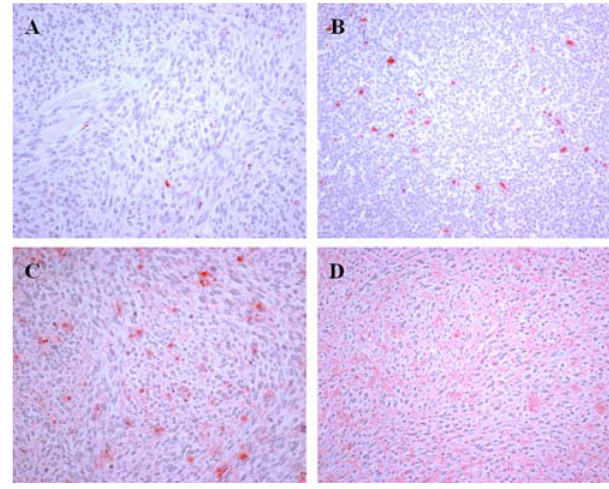
Figure 3. Analysis of tumor evolution by HES histological staining after IRE. A: control; B, C, D, E and F: respectively 1, 2, 6, 24 and 48 h after IRE.